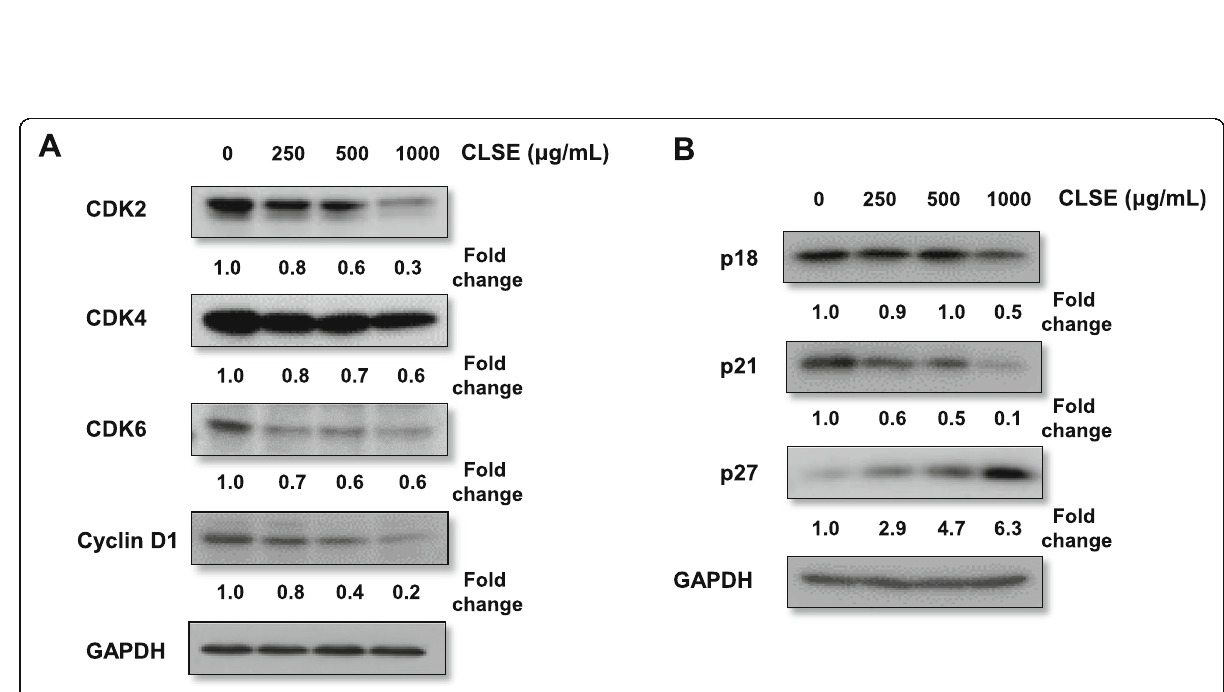
Fig. 3 Effects of Coix lacryma-jobi sprout extract (CLSE) on the modulation of cell cycle regulatory proteins. a, b After HeLa cells were treated with CLSE for 72 h, the expression of cell cycle regulatory proteins (CDK2, CDK4, CDK6, cyclin D1, p18, p21, and p27) was examined using western blot